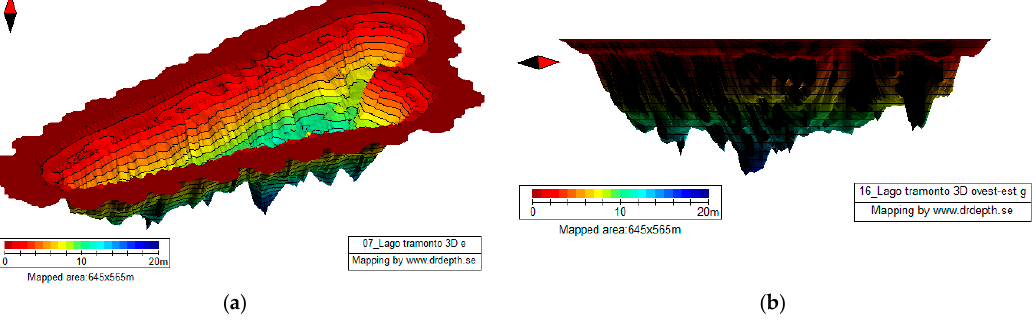
Figure 4. Tridimensional elaborations of Lago Tramonto in Gambulaga, Portomaggiore (FE, Italy): ( a ) 3D bathymetry; ( b ) 3D section West-East (using Hydrosynergy). From the database of the scanned lake-bottom, we detected 25 anomalies, both natural and artificial. The archaeological evidence was concentrated predominantly in the northern sector of the lake, at a depth between 4–12 m (Figure 5a,b).